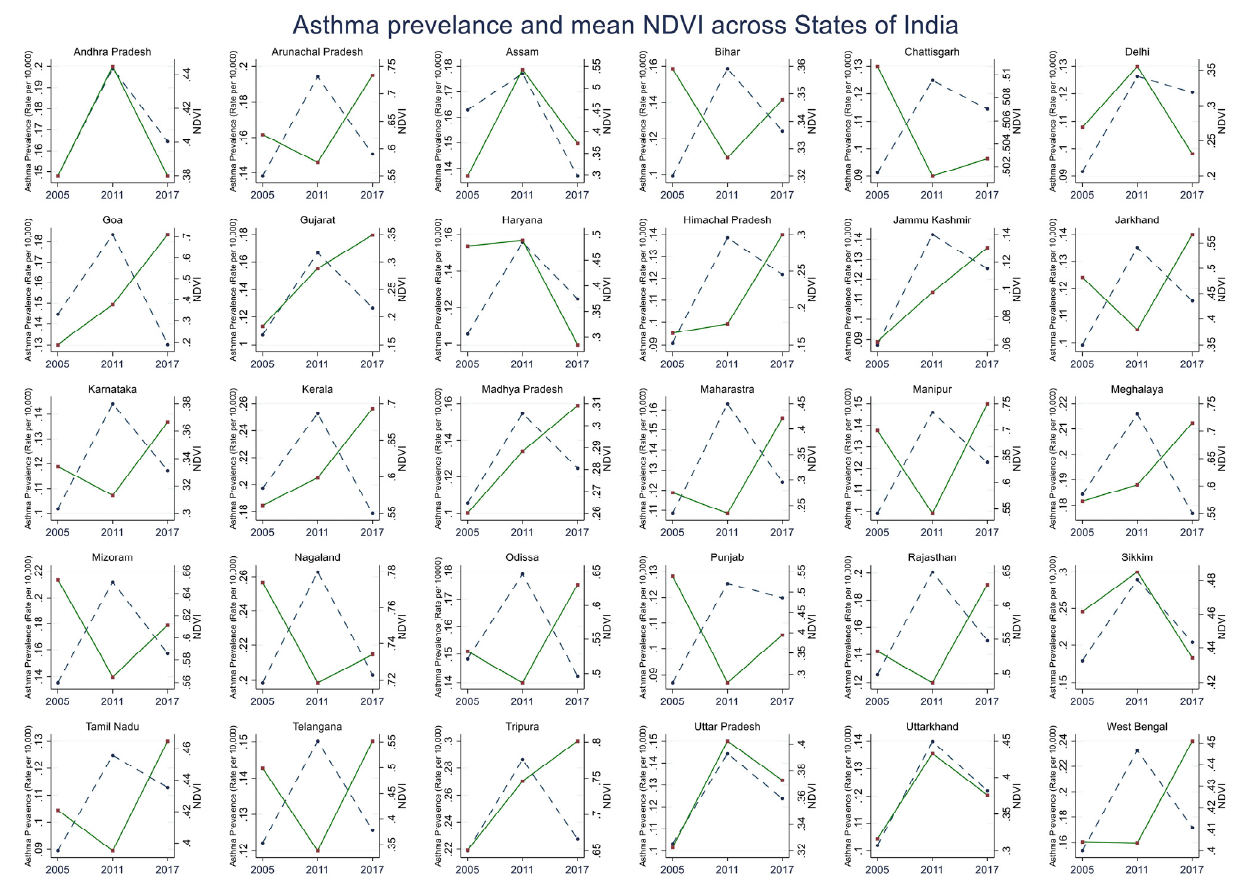
Figure 2. Asthma prevalence rate (per 10,000 population) and mean NDVI across 29 states and 1 union territory (SUTs) of India in 2005, 2011, and 2017.